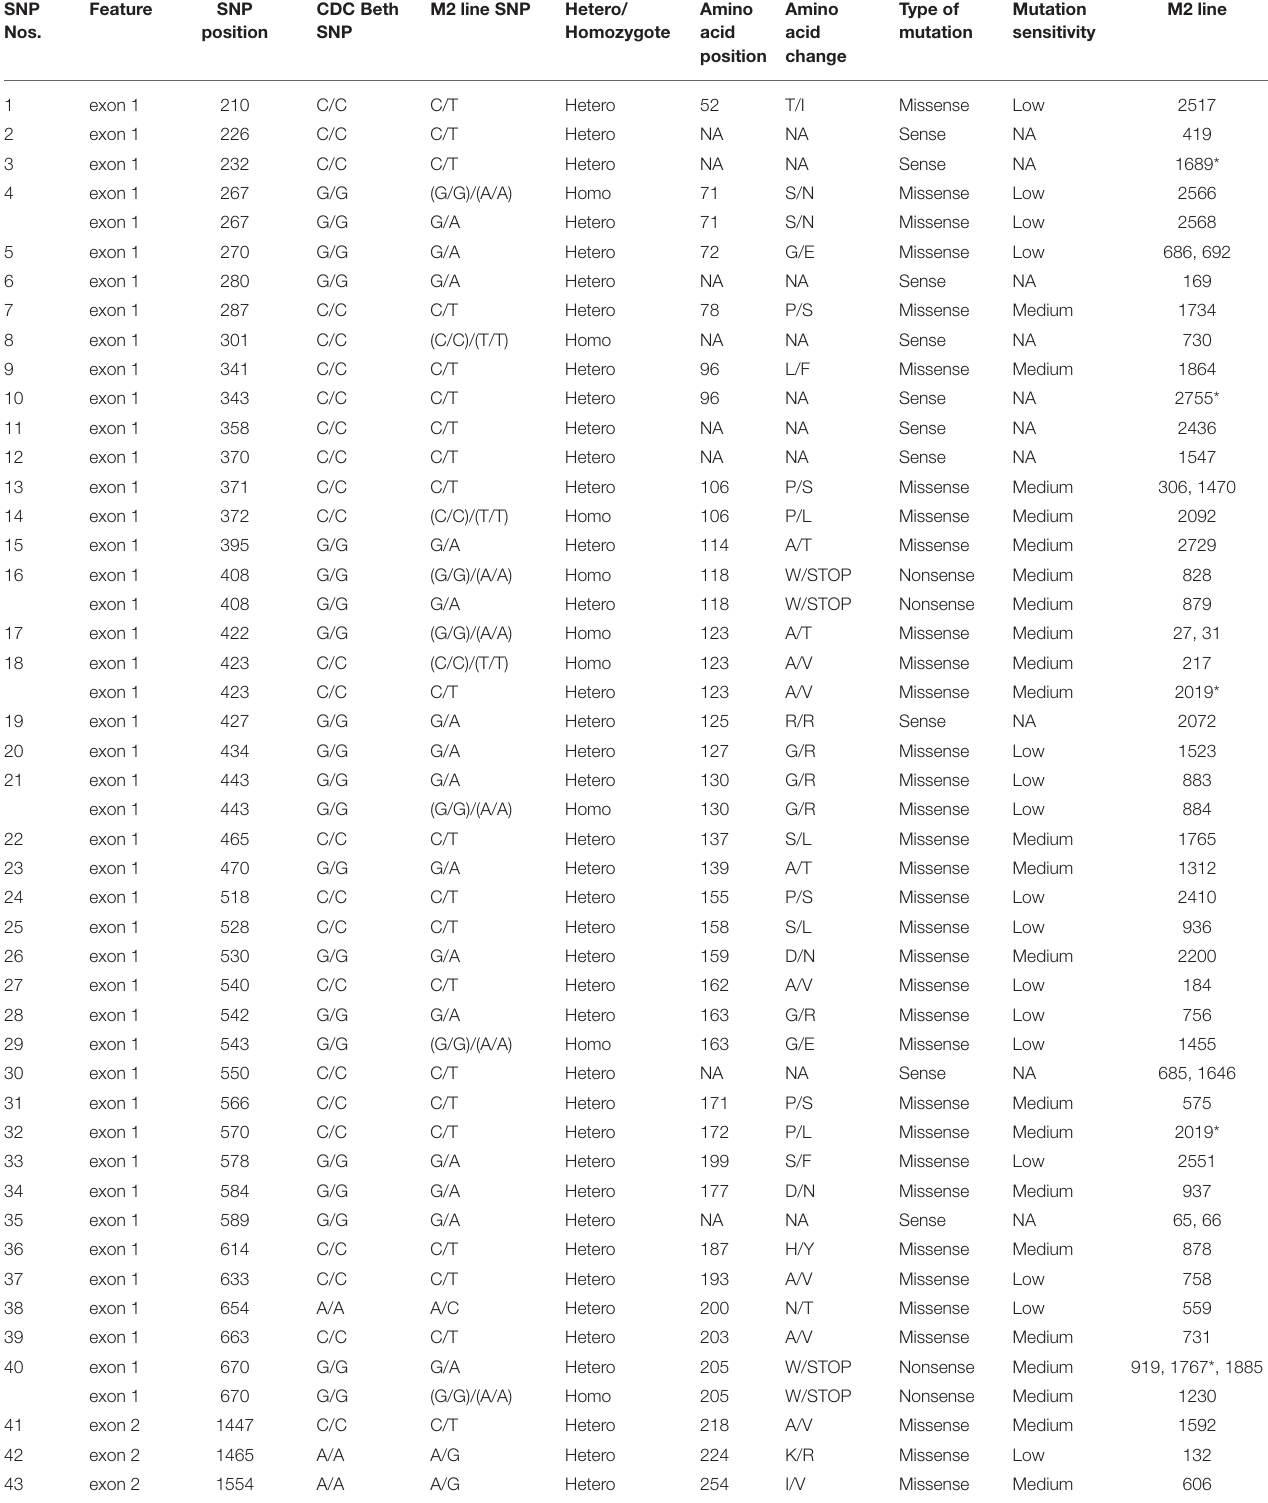
TABLE 3 | Details of 79 exonic mutations observed in UGT74S1 of 93 M2 flax plants. SNP